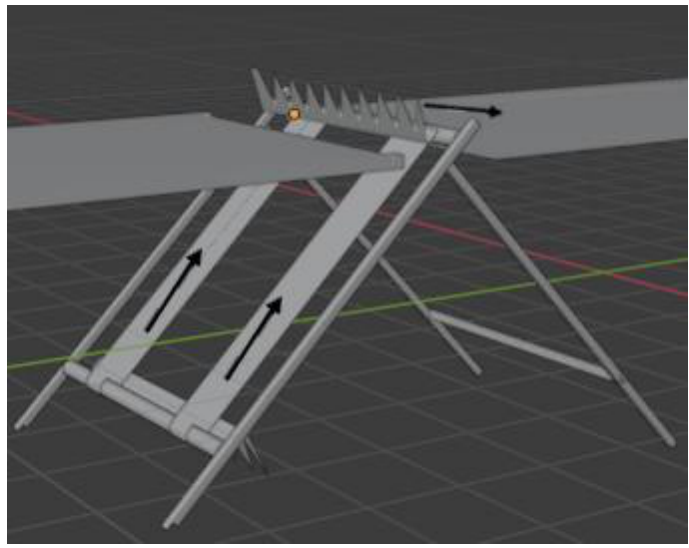
Figure 5. Hardware configuration in 3D design.